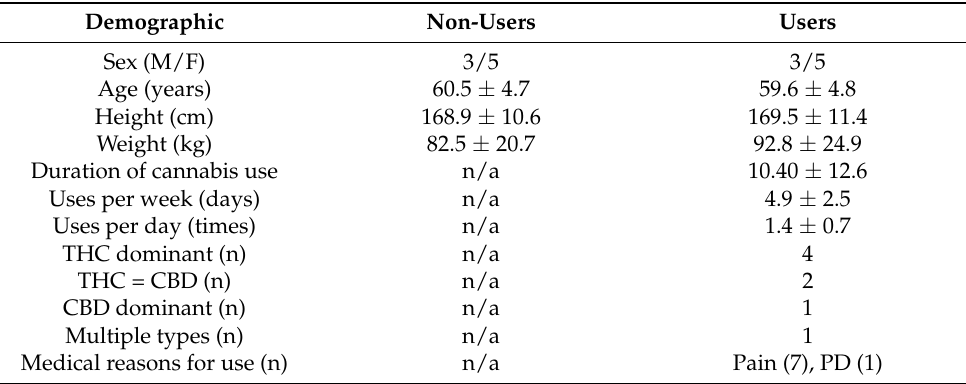
Table 1. Subject demographic information stratified by user status. Data are mean ±